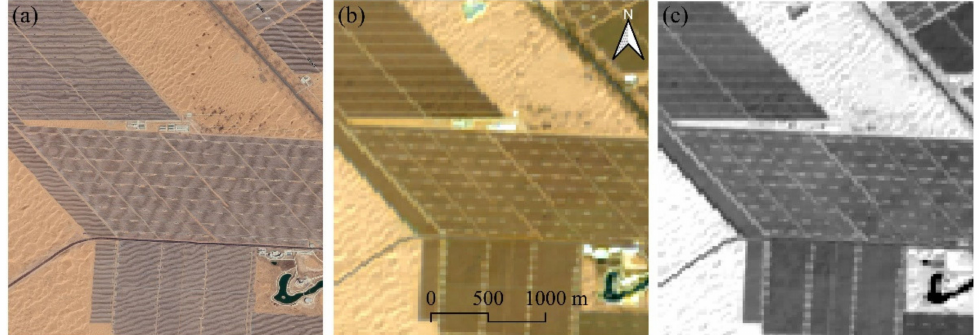
Figure 7. An example to show the texture of PV power plant from Landsat-8 imagery. ( a ) the true-color imagery from Google Earth, ( b ) the true-color imagery from Landsat-8, and ( c ) the gray-scale imagery from B5 of